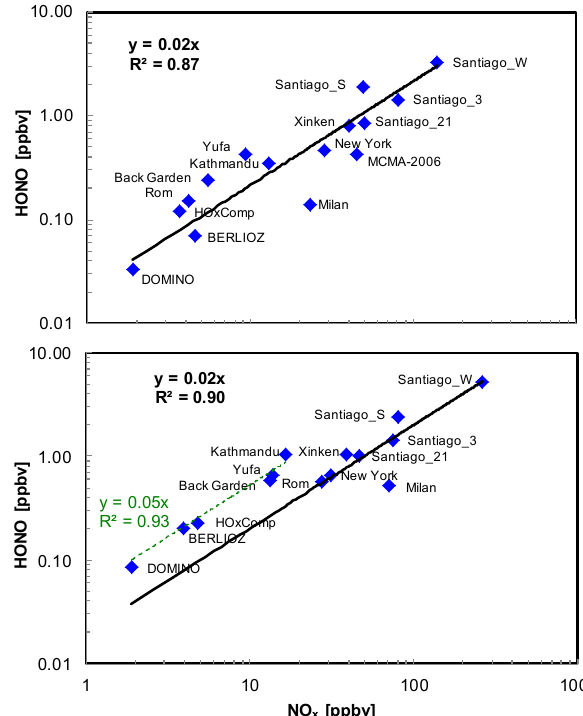
Fig. 3. Correlation between daytime (upper panel) and 24h (lower Figure 3: Correlation between daytime (upper panel) and 24 h average HONO and NO x panel) average HONO and NO x mixing ratios observed in differ- ent field measurement campaigns. For details and references, see mixing ratios observed in different field measurement campaigns. For details and Table 1 and the references, see Table 1 and the text.